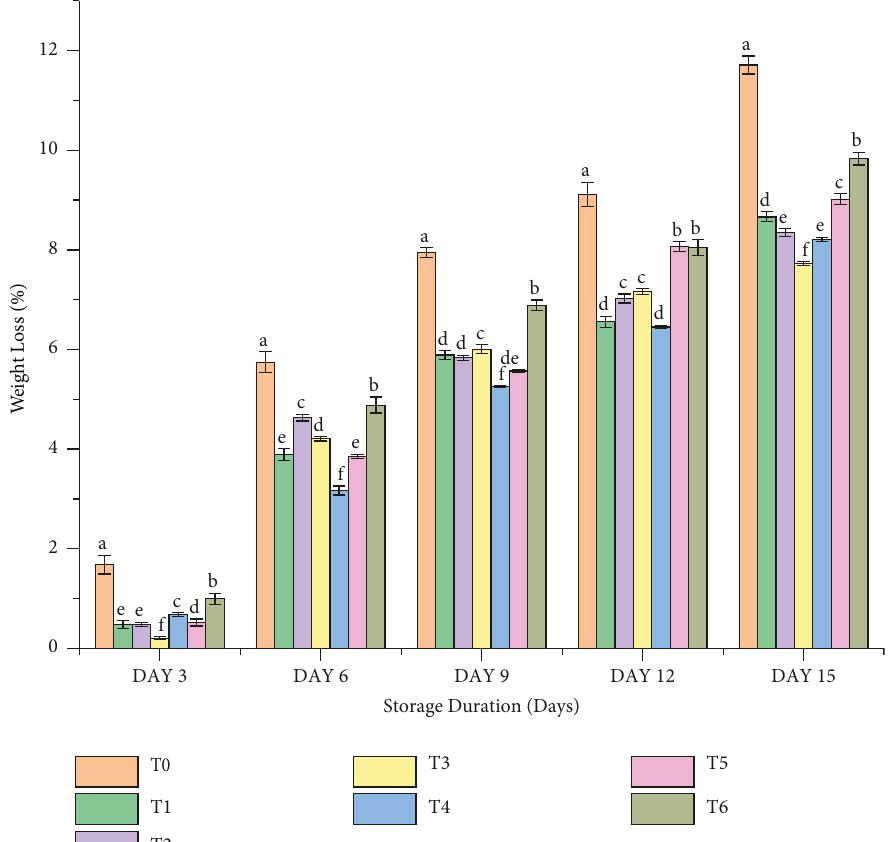
Figure 2: Effect of chitosan coating and cinnamon essential oil on weight loss of pomegranate arils during storage at 4 ± 1 ° C. Vertical bars represent the mean ± SD of 3 replicates. Error bars with different letters on the same storage period show a significant difference ( P ≤ 0 . 05). T0 � control; T1 � 1% chitosan+0.25% oil; T2 � 1% chitosan+0.5% oil; T3 � 2% chitosan+0.25% oil; T4 � 2% chitosan+0.5% oil; T5 � 3%